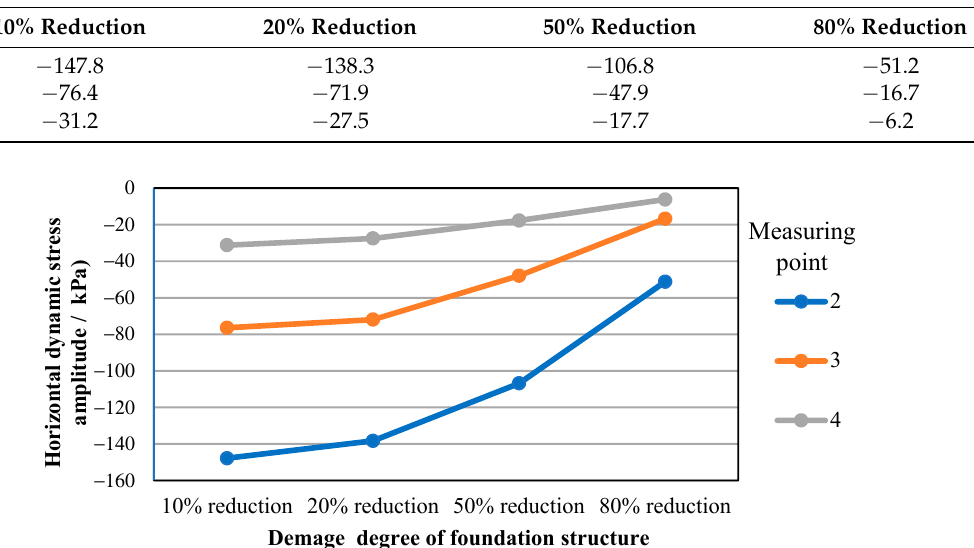
Figure 11. Horizontal dynamic stress amplitudes diagram of measuring points 2, 3, and 4 under different degrees of damage to the foundation structure.